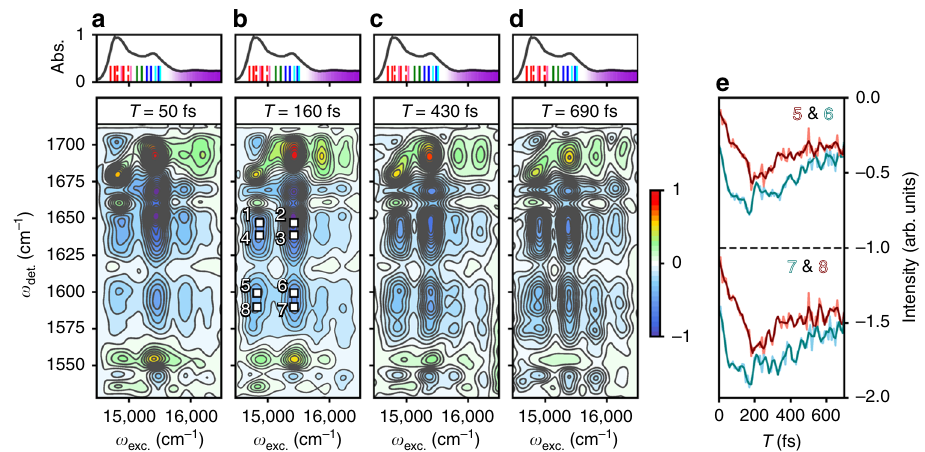
Fig. 2 Two-dimensional electronic-vibrational spectra of LHCII at 77 K. a – d 2DEV spectra of LHCII at waiting times of T = 50, 160, 430, and 690 fs, respectively. Positive features indicate ground state bleaches and negative features indicate excited state absorptions (ESAs). The intensities of all spectra have been normalized to T = 0 fs. Contour lines are drawn in 6.6% intervals. The region of the linear absorption spectrum of LHCII (at 77 K) that was excited during this experiment (the Q y bands), along with the excitonic states described in Fig. 1, has been placed at the top of each of the 2DEV spectra in ( a – d ). The grouping of red and pink lines distinguishes the excitonic band of mainly Chl a character, while the grouping of blue lines distinguishes the excitonic band of mainly Chl b character. The purple continuum highlights the region of the absorption spectrum composed of the higher-lying vibronic states of mixed Chl character. In ( b ), ESA features of interest have been labeled. e Example of the observed oscillatory intensities, for ESAs fi ve through eight. The intensity dynamics for seven and eight have been offset for clarity. The un fi ltered intensities are shown in light red and blue, while the data in dark red and blue has been subjected to a 1200 cm − 1 cutoff fi lter, in order to highlight the lower frequency oscillations of interest.